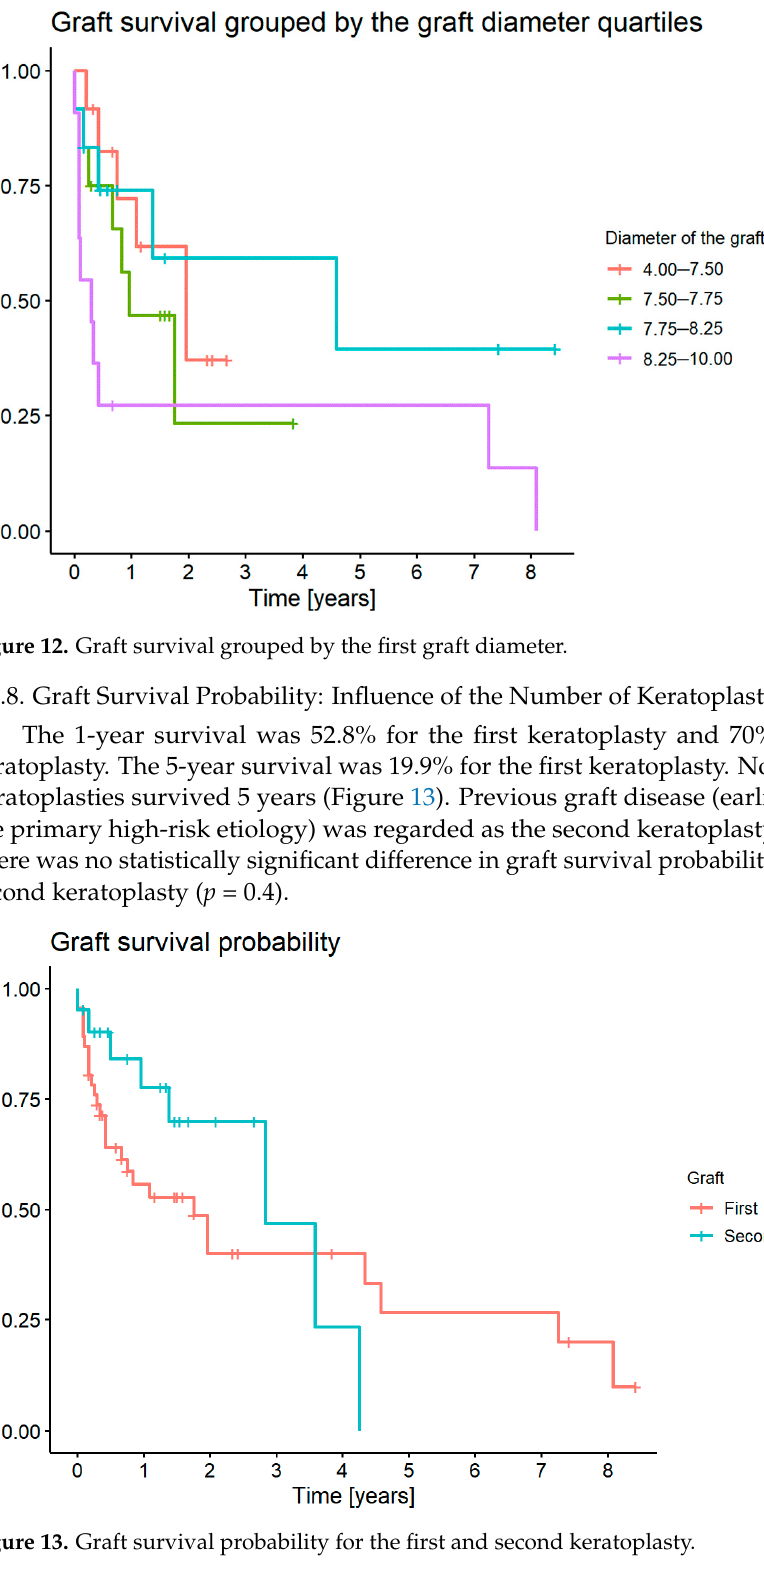
Figure 11. Graft survival grouped by the use of immunosuppression.